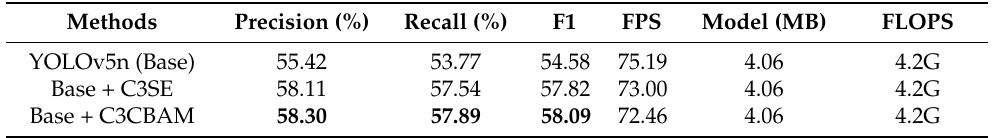
Table 3. Performance comparison of different attention modules.